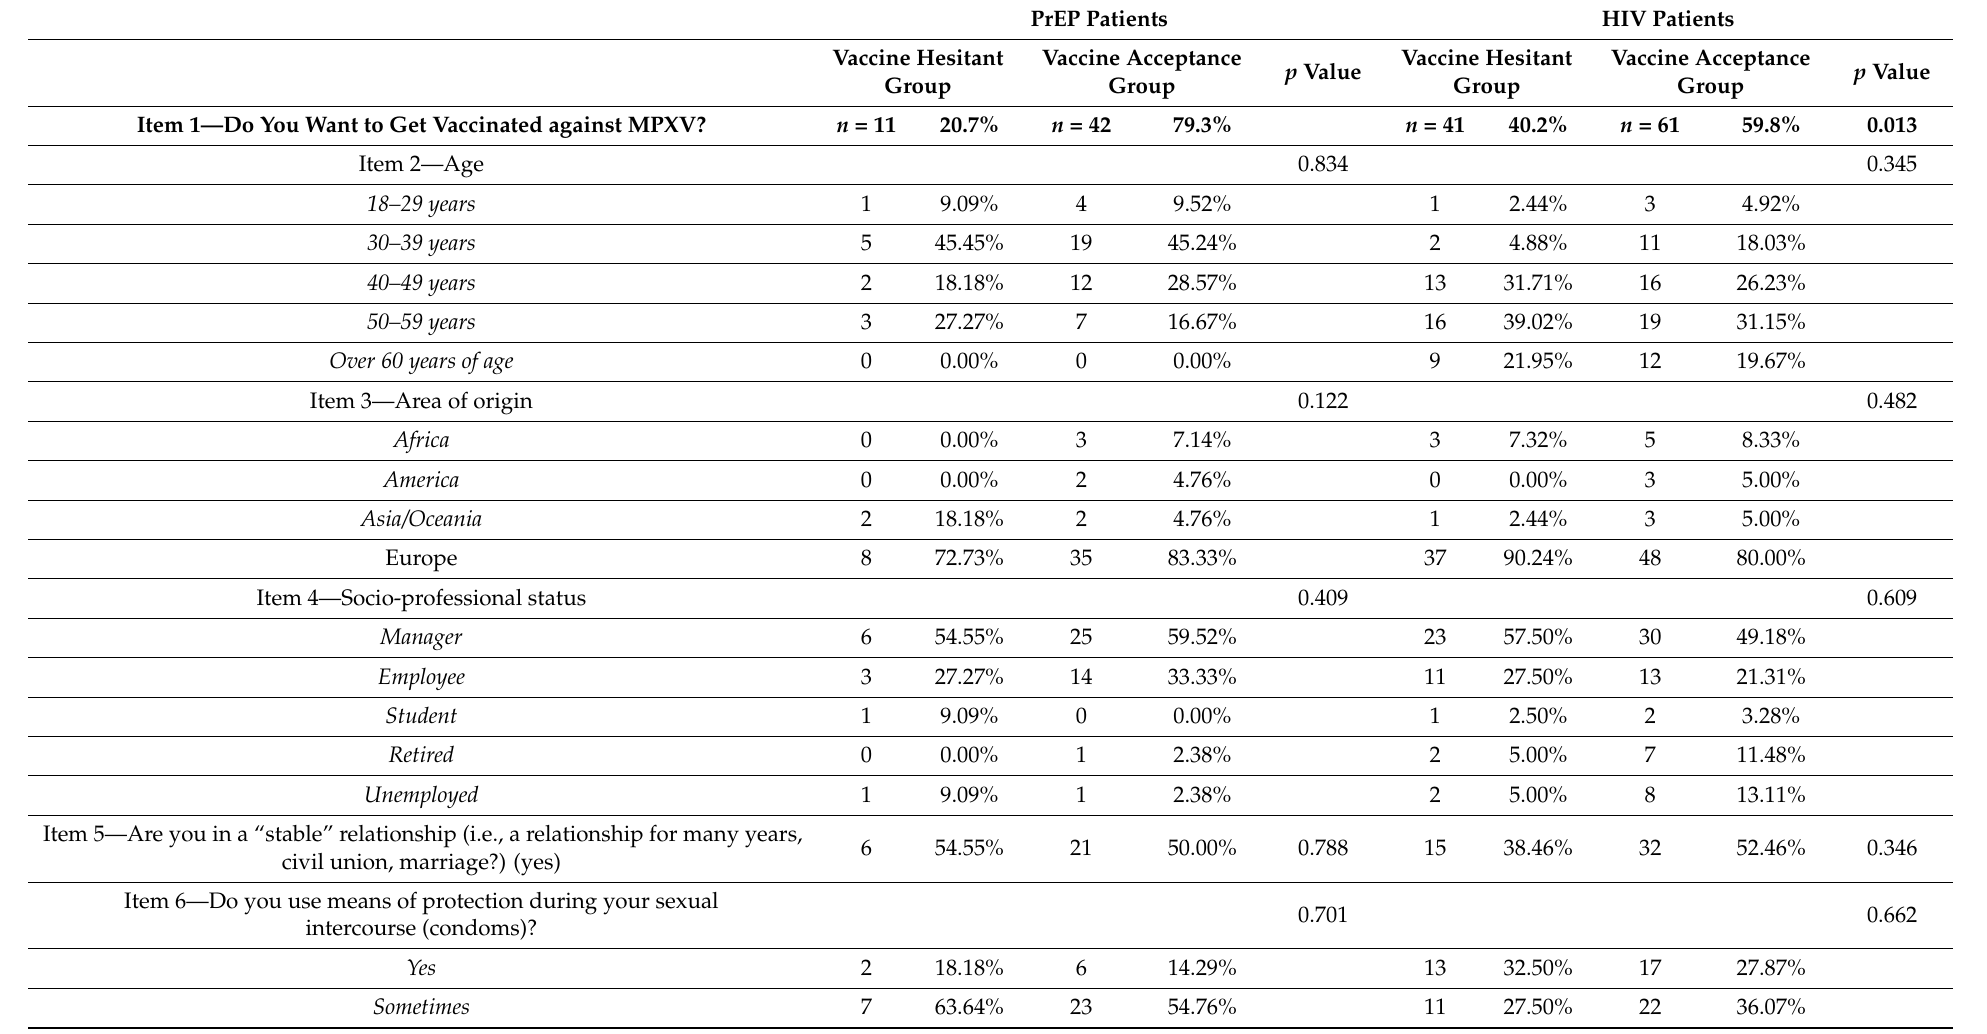
Table 2. Survey responses among the smallpox vaccine acceptance and hesitant groups in PrEP and HIV